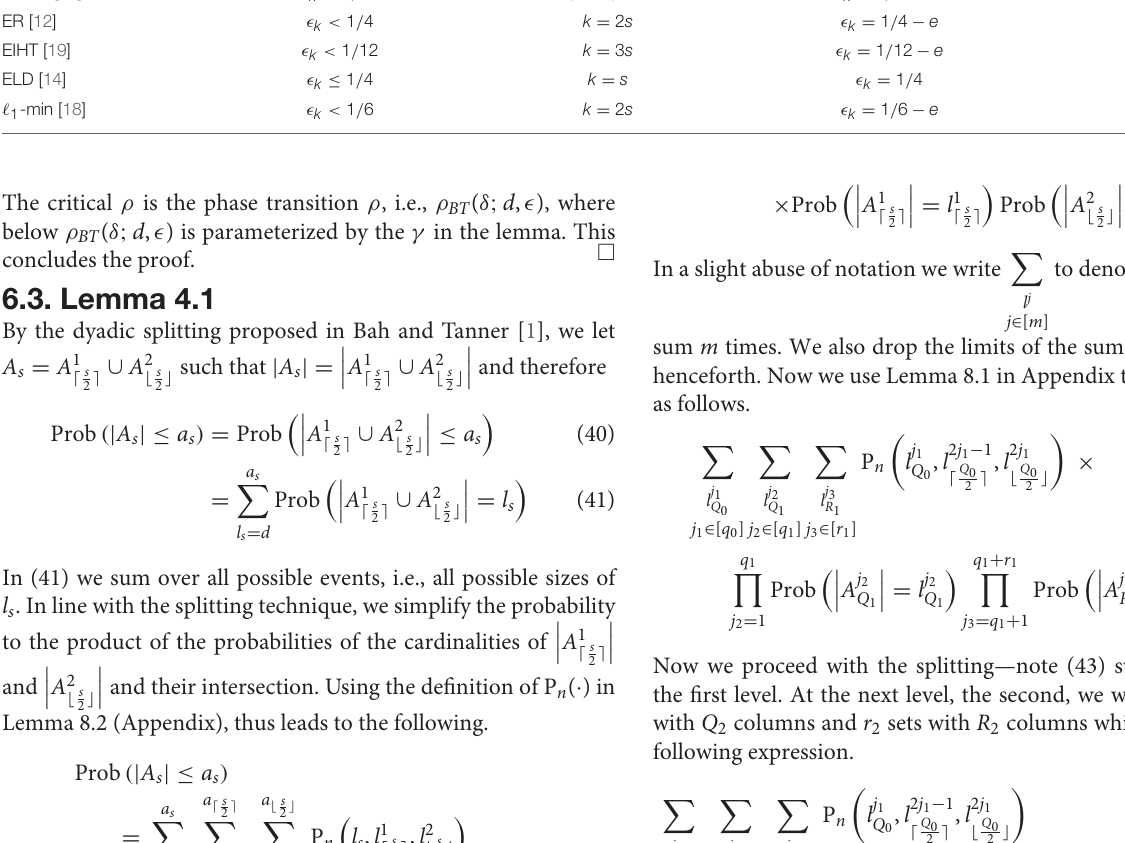
Theoretical values Computational